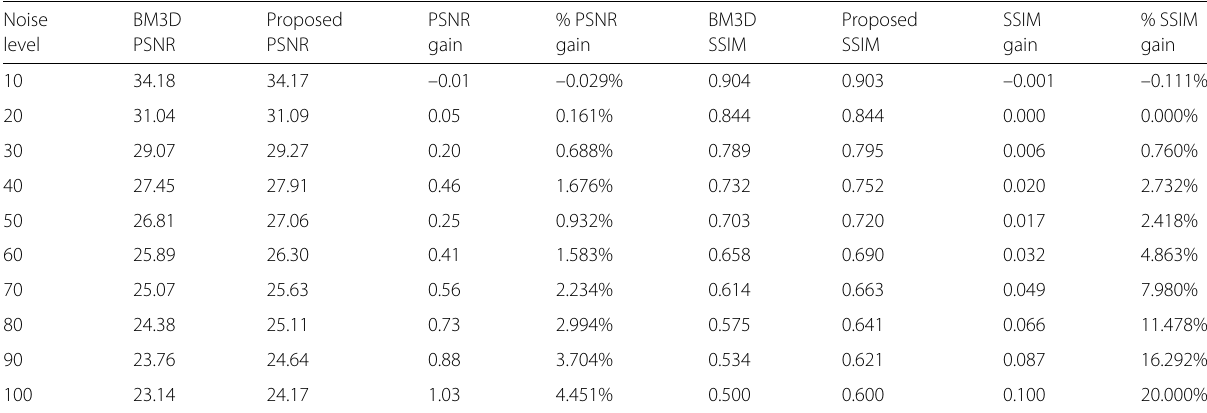
Table 3 Performance comparison of fast profile and the proposed method Noise BM3D